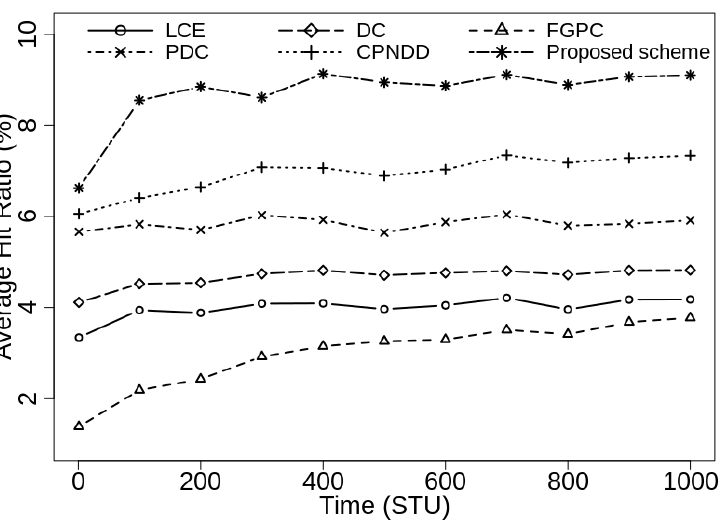
Figure 5. Comparison of cache hit-ratio (%) with λ = 50/s, | CS ( R i ) | = 100, α = 0.7, and | Ctlg | =